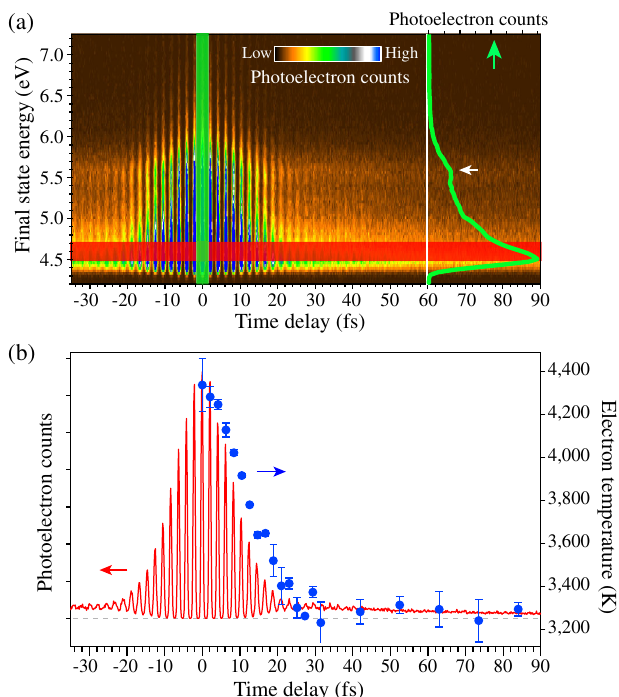
FIG. 5. Interferometric two-pulse correlation (I2PC) measure- ments of mPP. (a) k ∥ ¼ 0 Å − 1 cut through a 3D movie of mPP intensity vs energy, momentum, and delay time τ , for excitation with p -polarized h ν ¼ 1 . 97 eV light. The integration of the mPP signal within the green shaded rectangle over τ gives the mPP spectrum at τ ¼ 0 (green line; the green arrow points to the intensity scale). The white arrow points to the IPS peak. (b) Integration of the mPP signal within the red shaded rectangle in panel (a) over E gives the I2PC trace at E ¼ 4 . 6 eV (red). The dashed line is the zero line for the I2PC scan. The blue dots give the hot electron temperature following the two-pulse excitation with s -polarized light for selected delays corresponding to an integral number of optical